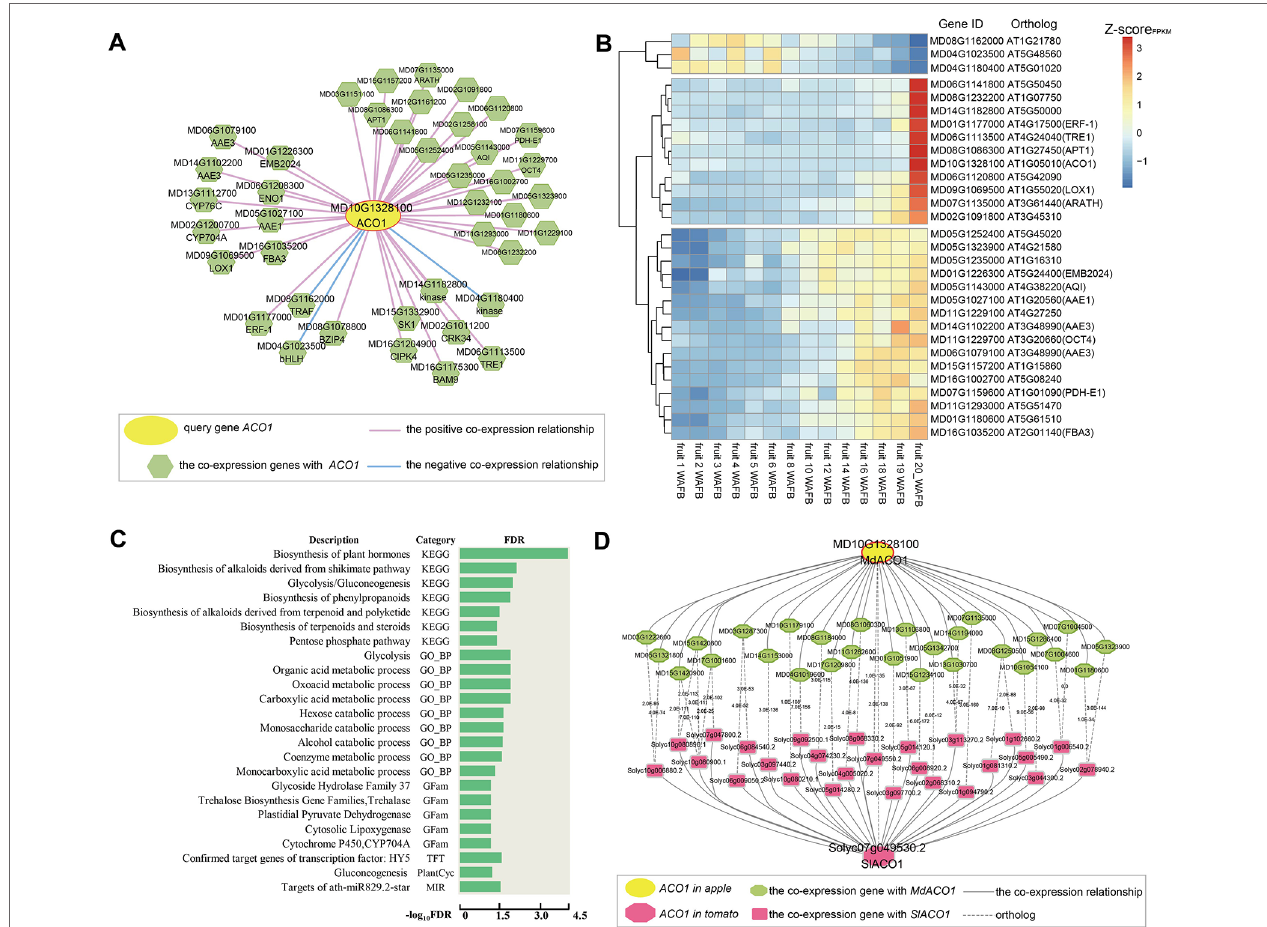
FIGURE 2 | Global co-expression network analysis of MdACO1 , associated with fruit ripening. (A) The global co-expression network of MdACO1 (MD10G1328100). The middle yellow circle is the ACO1 gene, and the surrounding green polygons are genes co-expressed with MdACO1 . The red line indicates positive co-expression with MdACO1, and the blue line indicates negative co-expression with MdACO1 . (B) Heatmap of all genes in the global co-expression network for MdACO1 . The redder the color is, the higher the expression level is, and the bluer the color is, the lower the expression level is. (C) Gene set enrichment analysis of all genes in the global co-expression network for MdACO1 by PlantGSEA (http://structuralbiology.cau.edu.cn/PlantGSEA). (D) Comparison of the top 300 genes in the global positive co-expression network between MdACO1 in apple and SIACO1 in